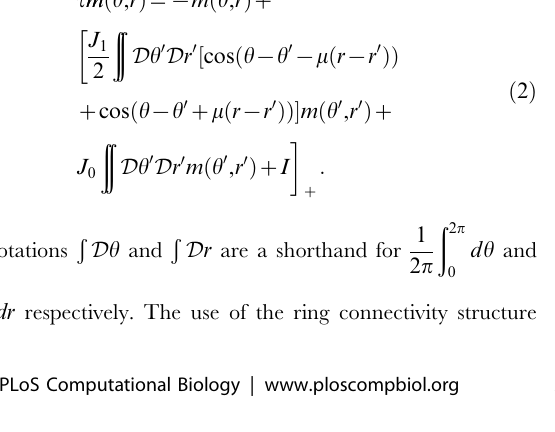
Figure 1. Construction of correlated maps. A: Cartoon showing how to generate two correlated maps A , B from neurons with randomly assigned index h on a reference ring, and distance value r [ { Given the distance between maps m [ ½ 0,1 (cid:2) ( 0 ? identical, 1 ? uncorrelated), the desired maps are created by adding and subtracting the value m r to the reference location h . The reference acts as an intermediate map, and the distance between maps limits the maximum distance between the location of the neurons on the maps A , B . B: Color codes corresponds to angles in map A (top panel) and B (bottom panel). The two plots show how neurons indexed by h A , h B are represented in h , r coordinates, for 1 . The particular neuron depicted in the cartoon is represented as a m ~ 2 dot.